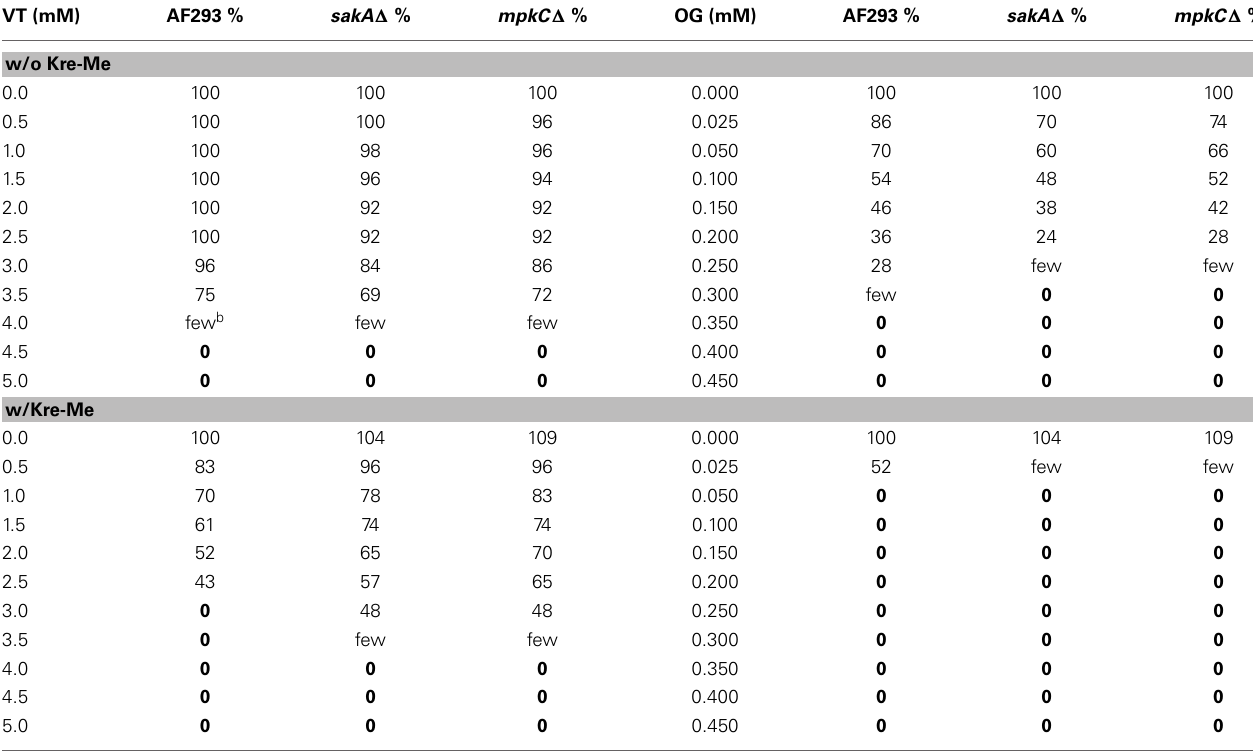
Table 3 | Responses of A. fumigatus WT and MAPK mutants to the treatments of benzo derivatives w/o or w/Kre-Me (25 µ M) a